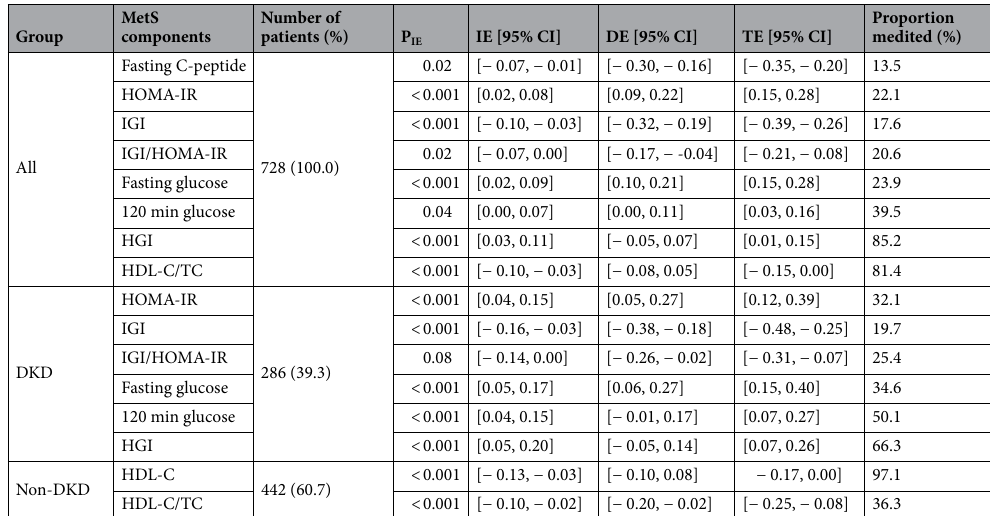
Table 4. DE, IE, and TE of MetS components on renal function impairment (eGFR) mediated through serum Mb (Significant). TE total effect, DE direct effects, IE indirect effects, CI confidence interval.